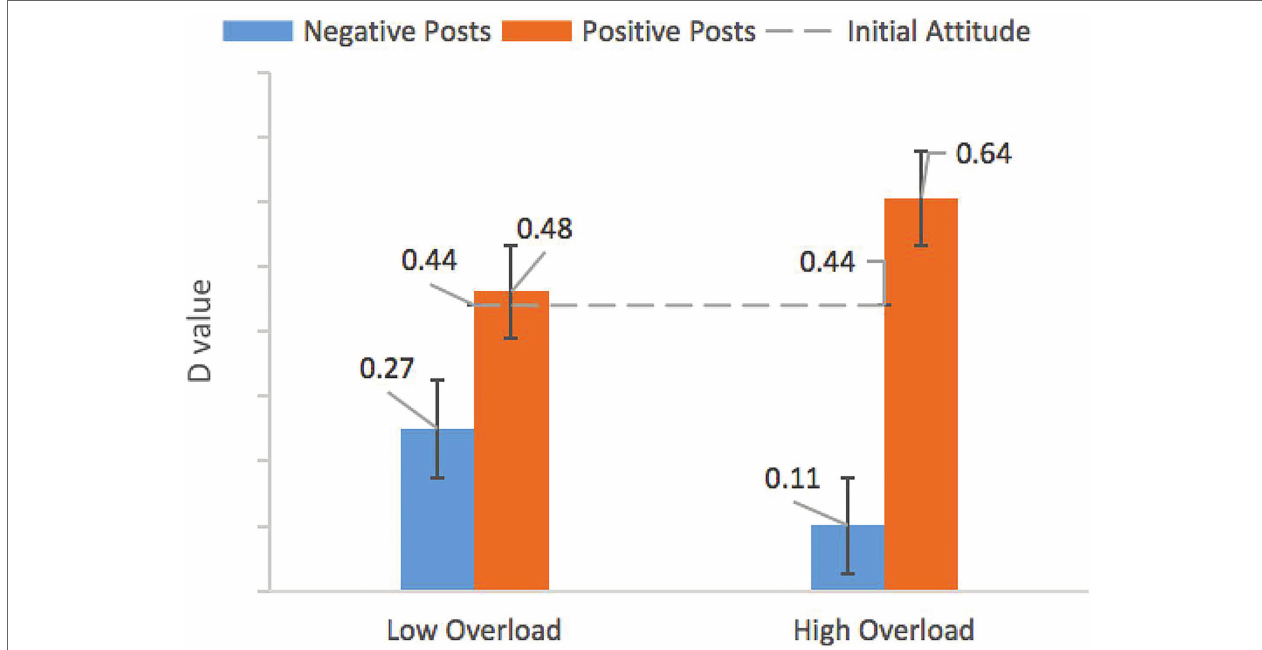
FIGURE 2 | D-values of SC-IAT under two information overload levels. Error bars represent